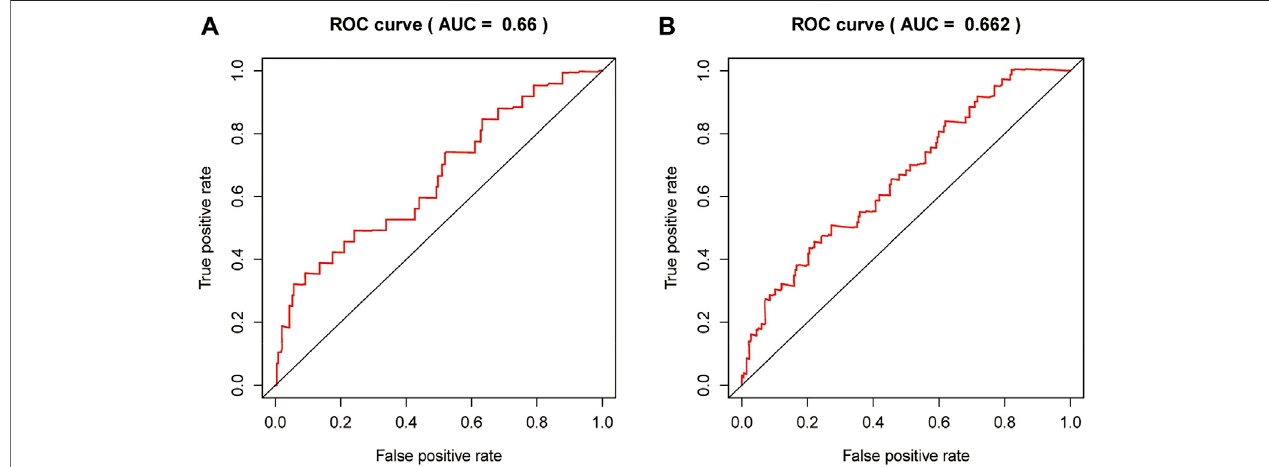
FIGURE 6 | Receiver operating characteristic (ROC) of 7 DEGRGs model in the training (I), test (J).